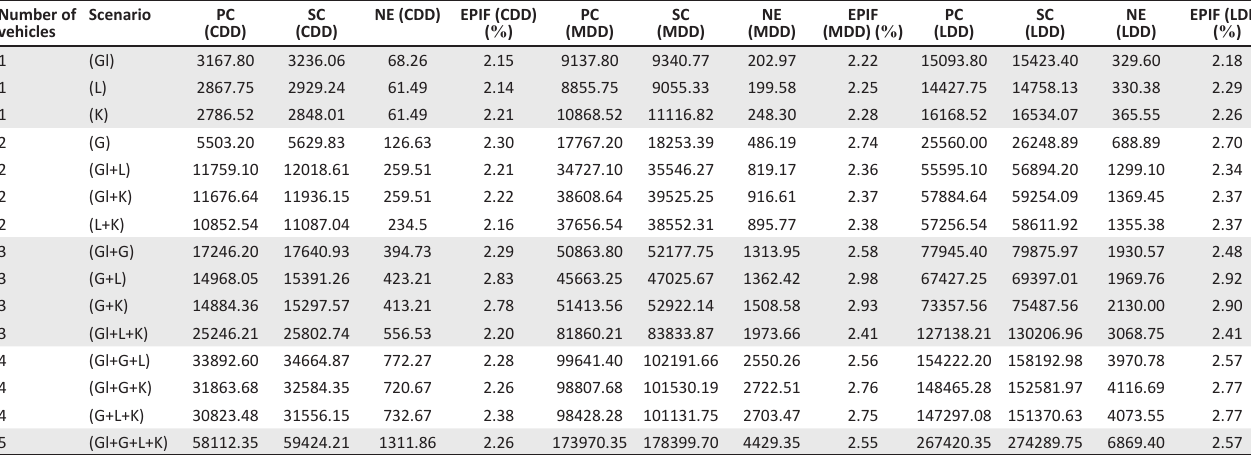
TABLE 1-A2: Scenario analysis